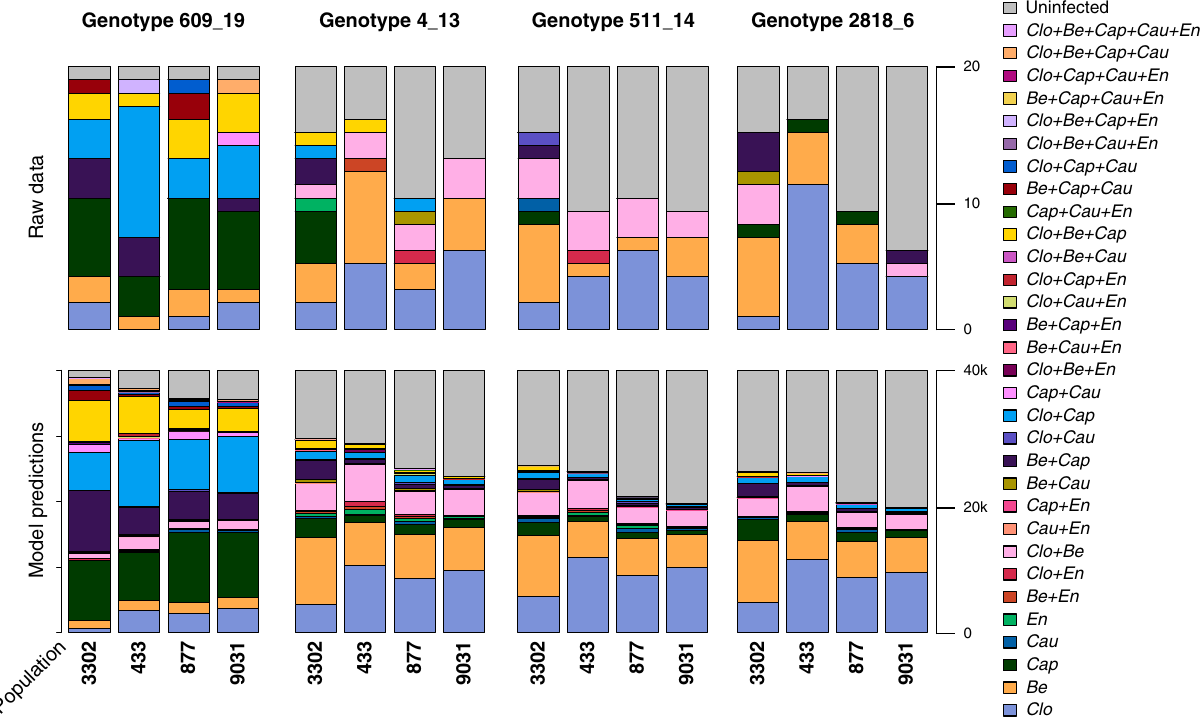
Fig. 2 (Co-)infections in the original data (upper panel) and predicted coinfections (lower panel) based on the model variant 2, ordered by host genotypes and population, as indicated by the X -axis. Both the genotypes and populations are ordered with respect to frequency, so that the bars on the left-hand side show the population and genotype with the highest total amount of virus infection. ‘ Clo ’ refers to Plantago closterovirus , ‘ Be ’ to Plantago betapartitivirus , ‘ Cap ’ to Plantago lanceolate latent virus , ‘ Cau ’ to Plantago latent caulimovirus , and ‘ En ’ refers to Plantago enamovirus . The total number of plants in the upper panel is 20, whereas in the lower panel the total number is simulated plants is 20 (original number of plants) times 2000 (number of MCMC iterations used for the simulation), resulting in 40,000 simulated